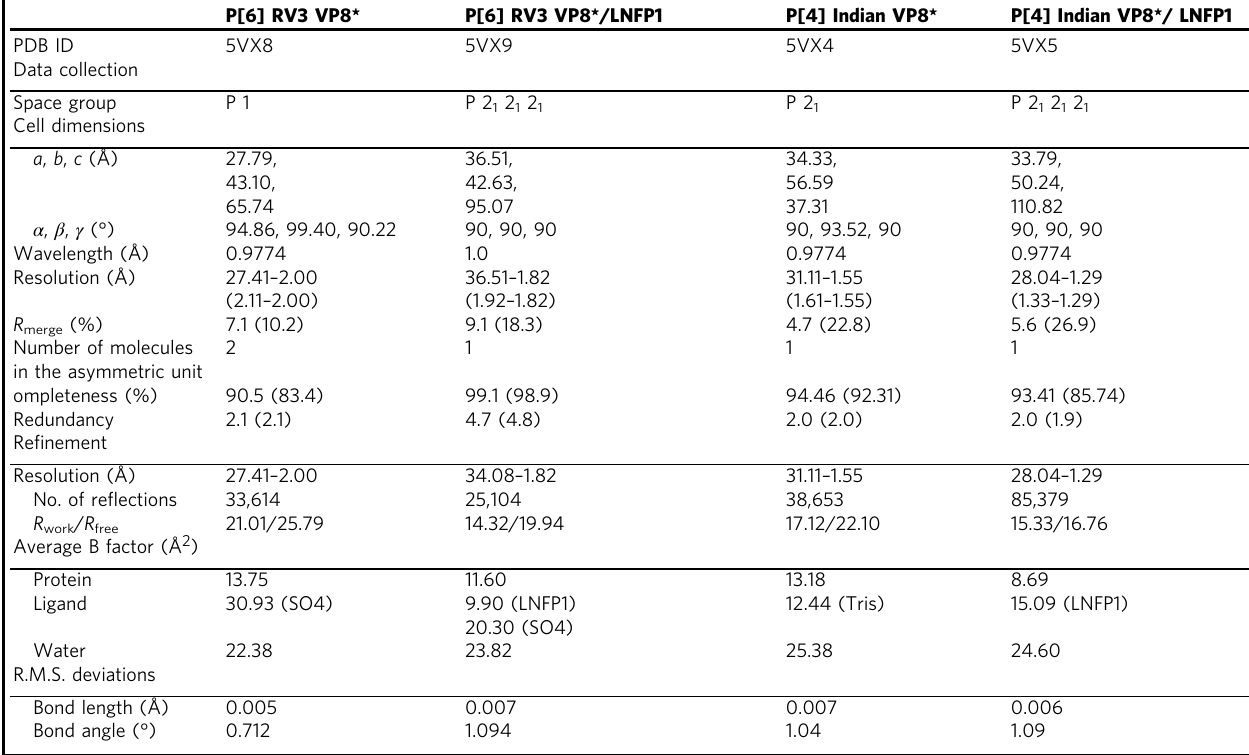
Table 1 Crystallographic statistics of P[6] RV3 VP8* and P[4] Indian VP8*